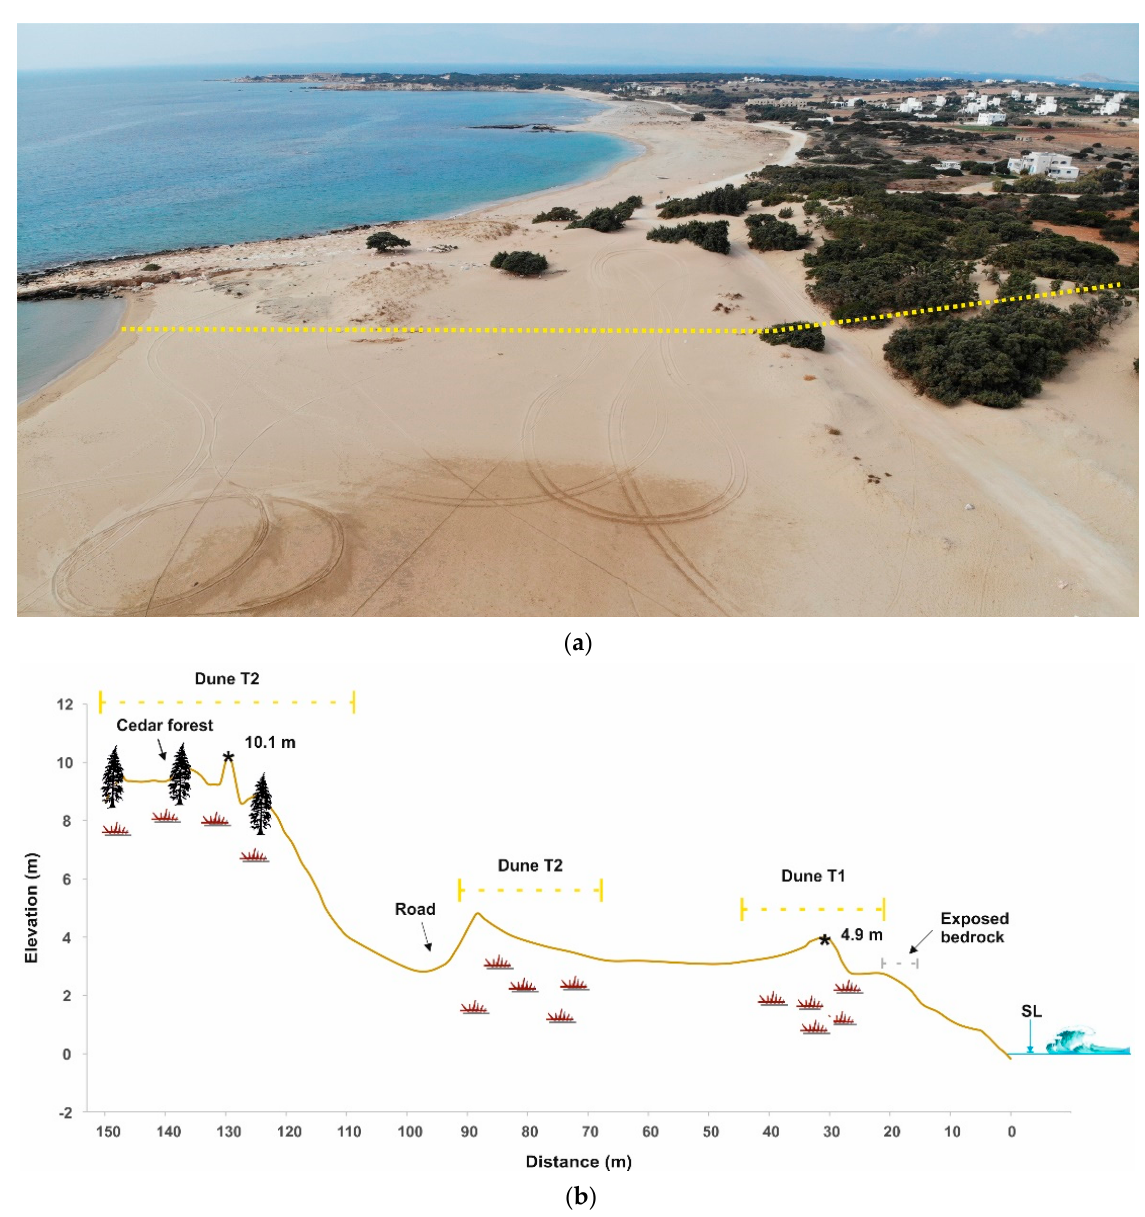
Figure 9. ( a ) Aerial photograph of Pyrgaki site, with the location of the section; Parts of granodiorite that have not been eroded protrude to the sea; ( b ) Sketch of the cross section.